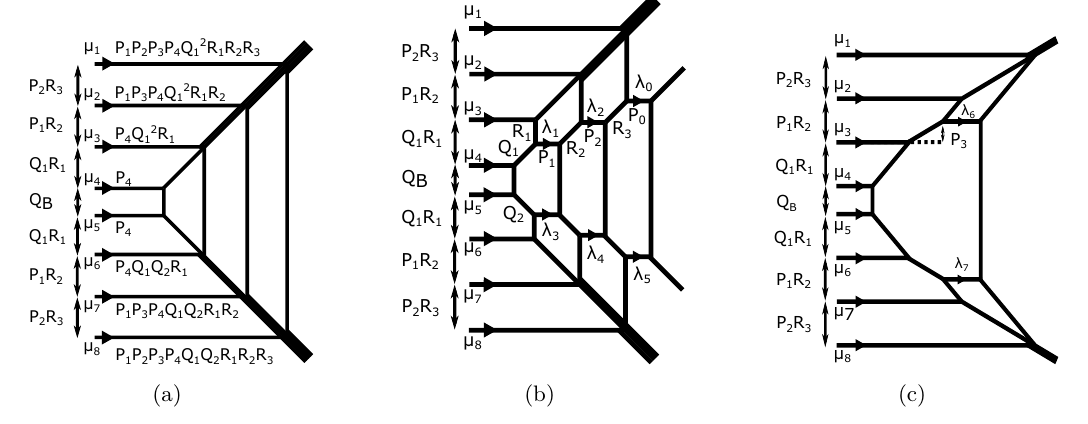
Figure 46. Parametrization of the web diagram for the geometry e (1)